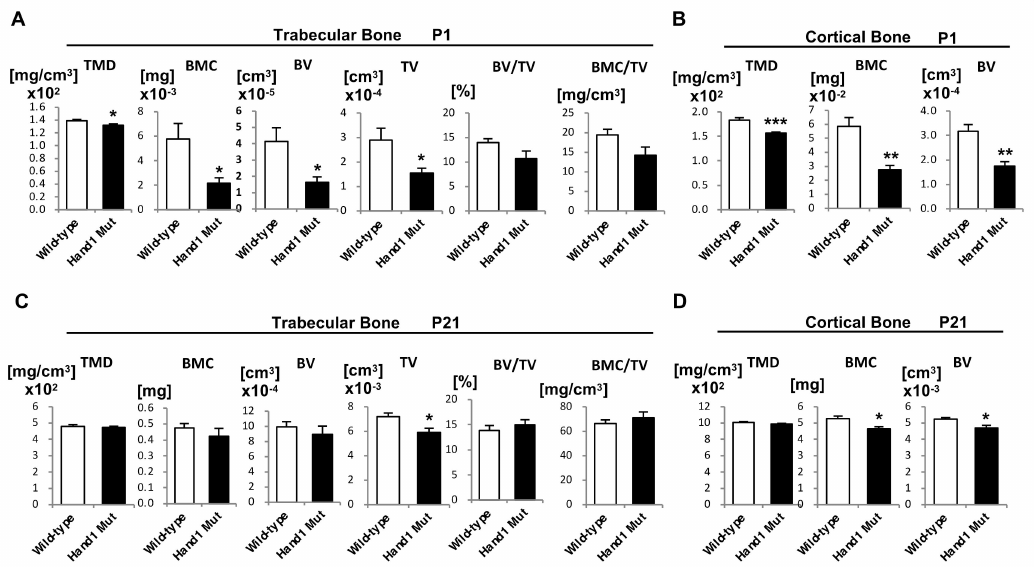
Figure 2. Micro-computed tomography (Micro-CT) analysis of femurs from Hand1 -overexpressing mice. ( A ) Micro-CT analysis of trabecular bones from the femurs of wild-type and Hand1 -overexpressing mice at postnatal day (P)1 ( n = 3 per genotype). ( B ) Micro-CT analysis of the cortical bone of femurs from wild-type and Hand1 -overexpressing mice at P1 ( n = 3 per genotype). ( C ) Micro-CT analysis of trabecular bones of femurs from wild-type and Hand1 -overexpressing mice at P21 ( n = 3 per genotype). ( D ) Micro-CT analysis of cortical bones of femurs from wild-type and Hand1 -overexpressing mice at P21 ( n = 3 per genotype). Analysis of structural parameters of wild-type and Hand1 -overexpressing mice indicated reduced cortical bone volume in the Hand1 -overexpressing mice. * p < 0.05; ** p < 0.01; *** p < 0.001 (compared to the wild-type). TMD, bone tissue mineral density; BMC, bone mineral content; BV, bone volume; TV, total volume of interest; BV / TV, trabecular bone volume fraction; BMC / TV, volumetric bone mineral